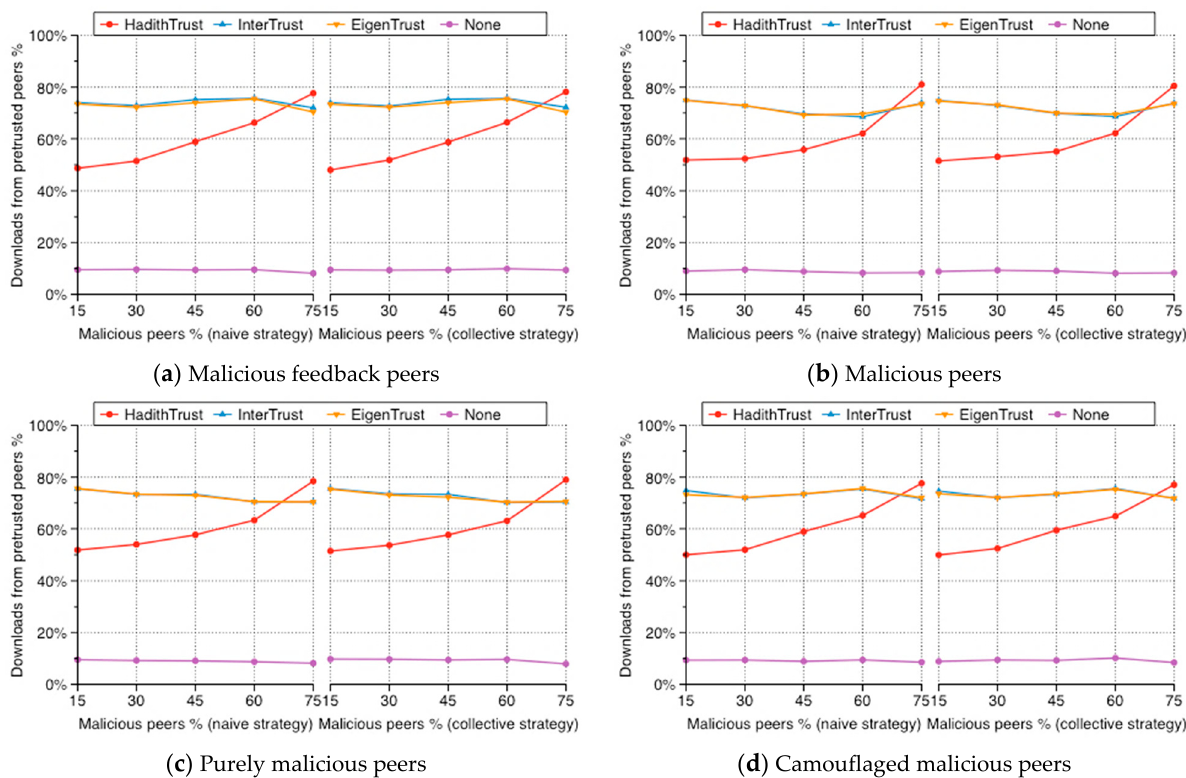
Figure 17. Percentage of good peers’ downloads from pretrusted peers.